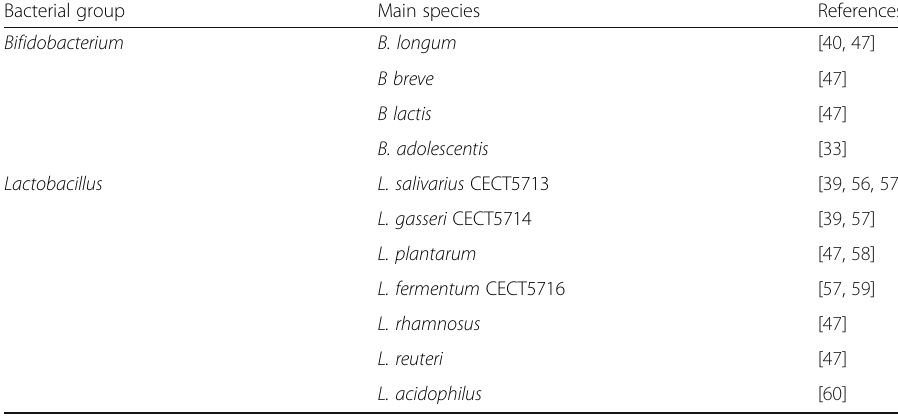
Table 2 Probiotic bacterial species isolated from the breast milk of healthy women Bacterial